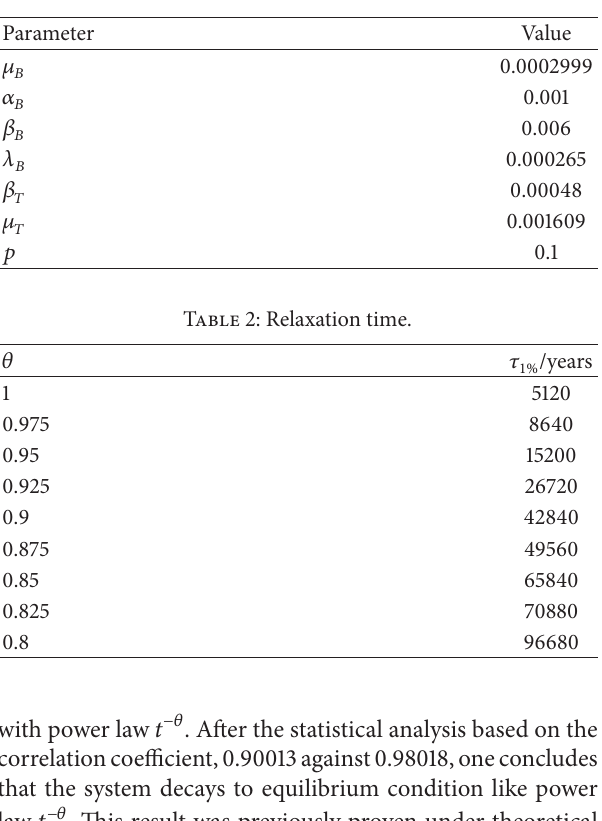
Table 1: The control parameters.